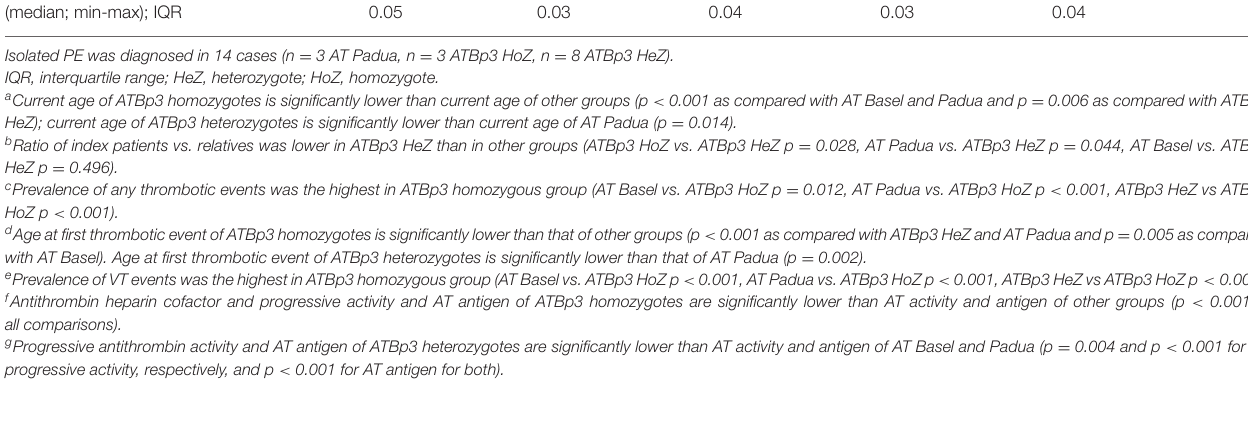
All ( n = 230) AT Basel AT Padua ( n = 9) ( n =